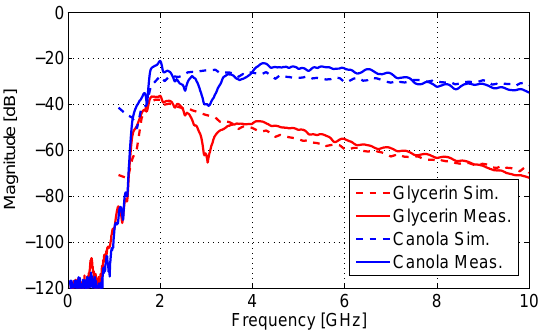
Figure 9. Comparison between simulated and measured results using canola oil and glycerin.